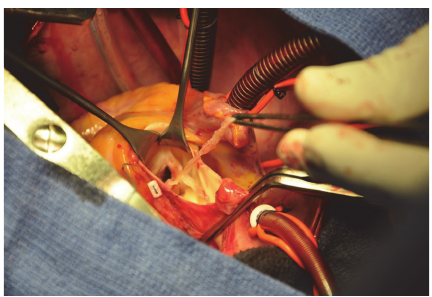
Figure 3: Removal of vegetation and aortic valve replacement using CPB—intraoperative